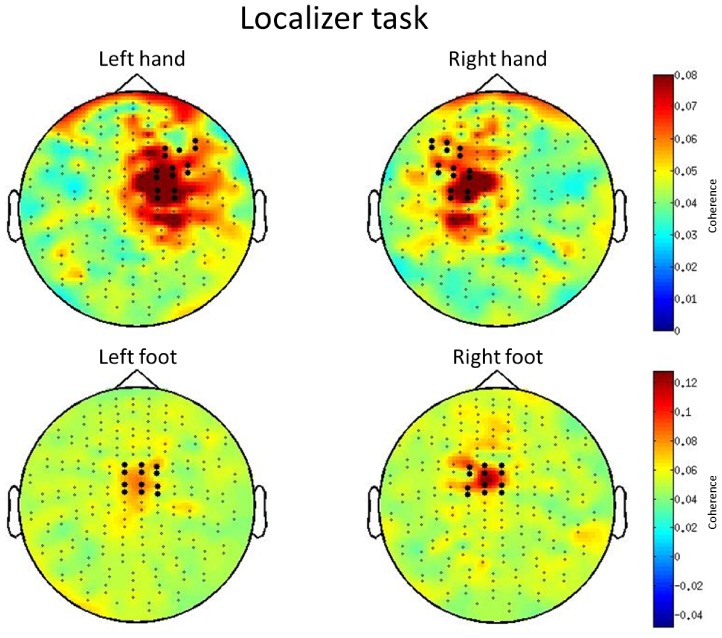
Grand-average of corticomuscular coherence in the beta (15–25 Hz) range related to hands (top) and to feet (bottom) isometric contraction across 15 subjects.Bold points represent gradiometer pairs selected for frequency analysis in the word paradigm.